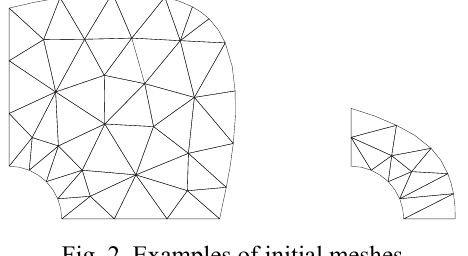
Fig. 2. Examples of initial meshes